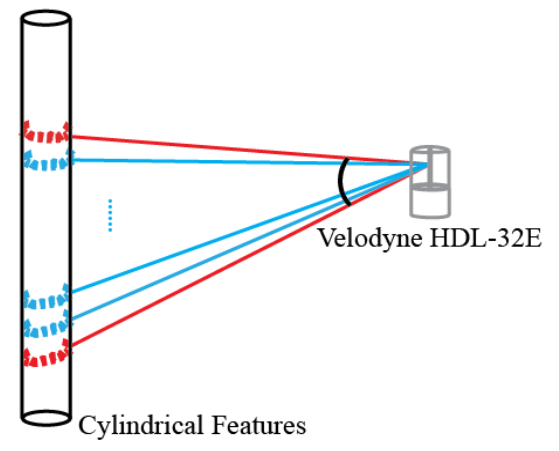
Figure 7. Configuration for constrained lasers for the calibration (red for the constrained lasers, blue for the lasers with error offsets estimated in the